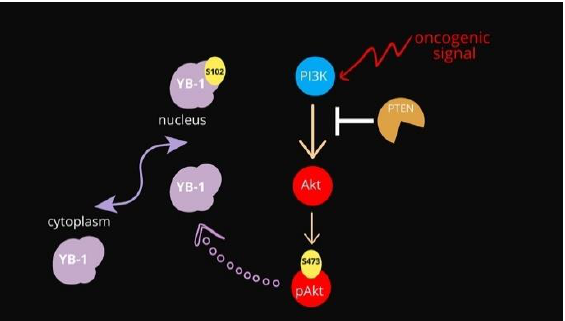
Figure 1. Schematic representation of the PI3K/AKT pathway overseeing YB-1